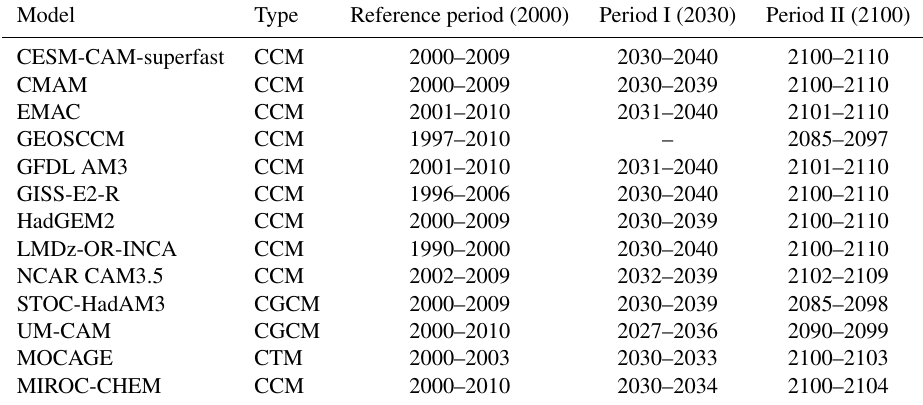
Table 3. List of the ACCMIP model used in this study and the time slice availability for each model. Model